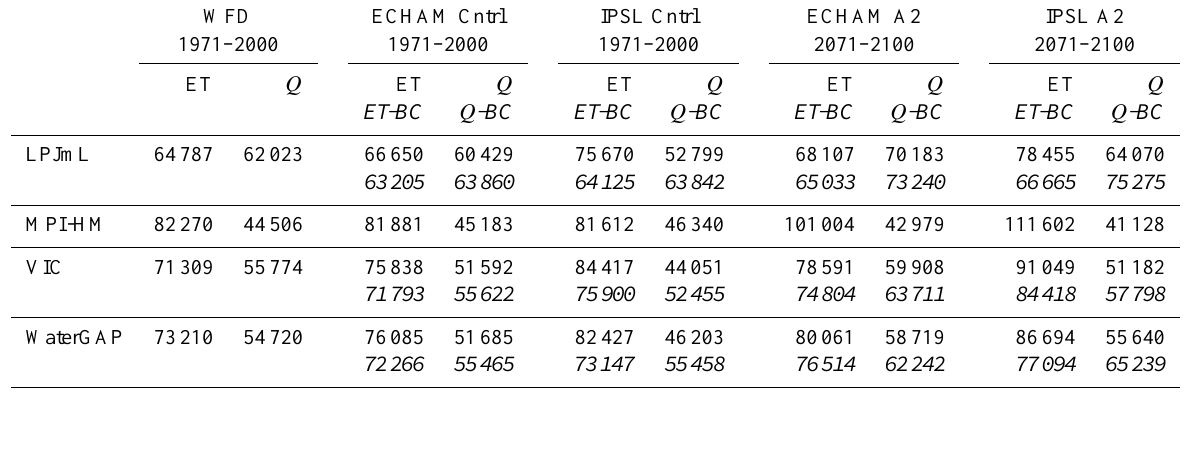
Table 2. Mean annual global terrestrial evapotranspiration (ET) and runoff ( Q ) numbers (km 3 yr − 1 ) for all model simulations included in this study. Original and bias corrected (BC) results for the control (1971–2000) and projection (2071–2100) periods.